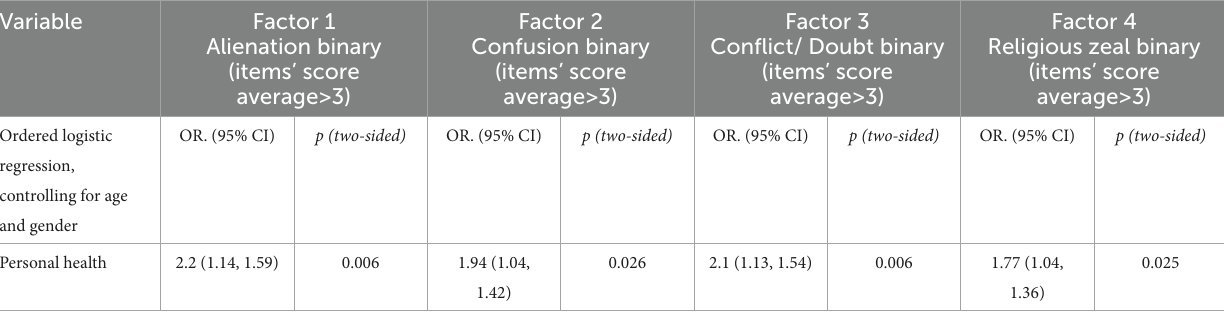
TABLE 5 Associations of new RSS sub-domains with self-rated health with six-point Likert scale (1 = excellent health, 6 = very poor health).